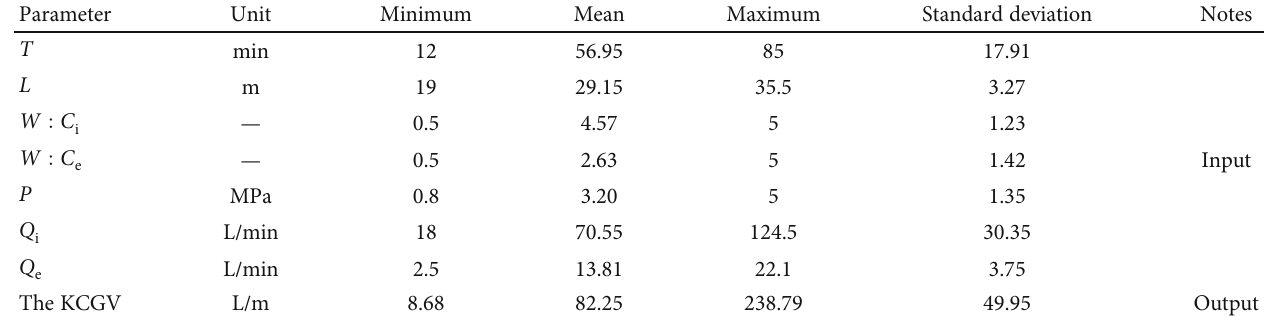
Table 2: The numerical statistics of input and output parameters.